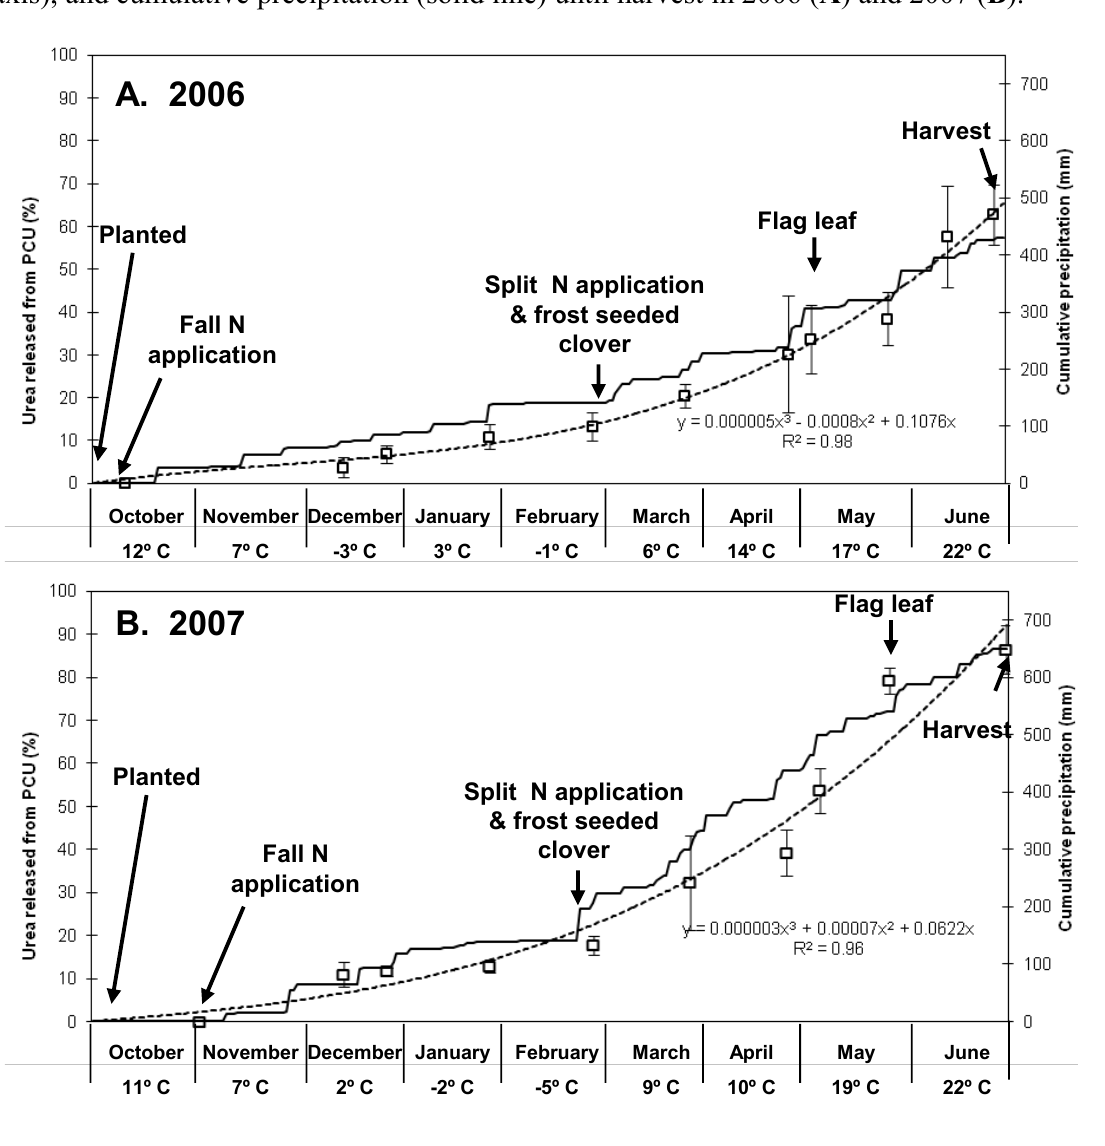
Figure 1. Urea released from polymer-coated urea (PCU) each month (squares with standard deviation whiskers), release curve (dash line), average monthly soil temperature (horizontal axis), and cumulative precipitation (solid line) until harvest in 2006 ( A ) and 2007 ( B ).